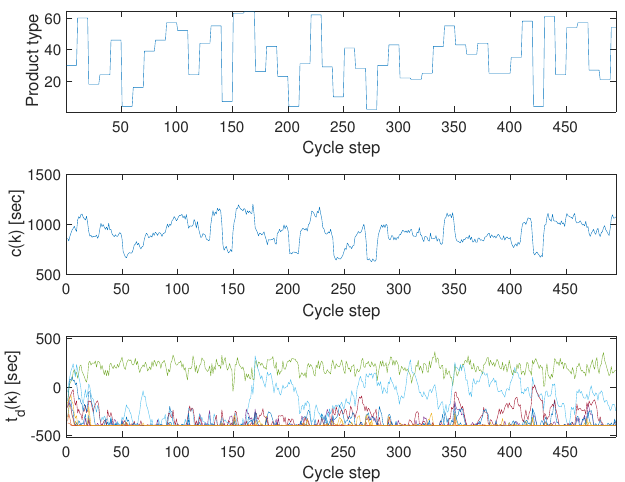
Figure 16. Production of N = 500 products in batches by applying model predictive control with regard to the cycle time of the wire-harness production line, H p = 5, H c = 3, α = 0.1. Control of the cycle time maximizes productivity, so performance is enhanced by 20% in this complex problem compared when the cycle time was constant. The bottom plot shows the time delay ( t d ( k )) at every workstation where the colours represent the